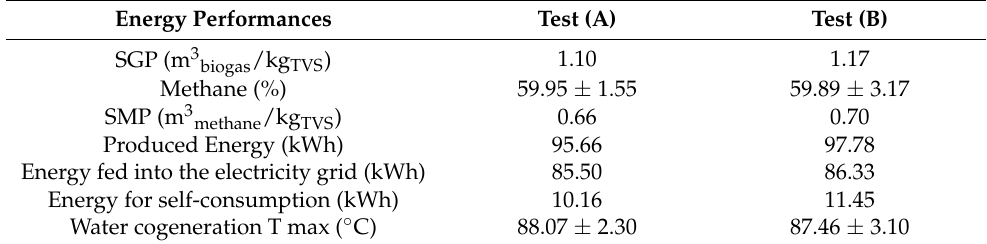
Table 4. Energy performances of the full-scale anaerobic digestion plant and cogeneration plant.